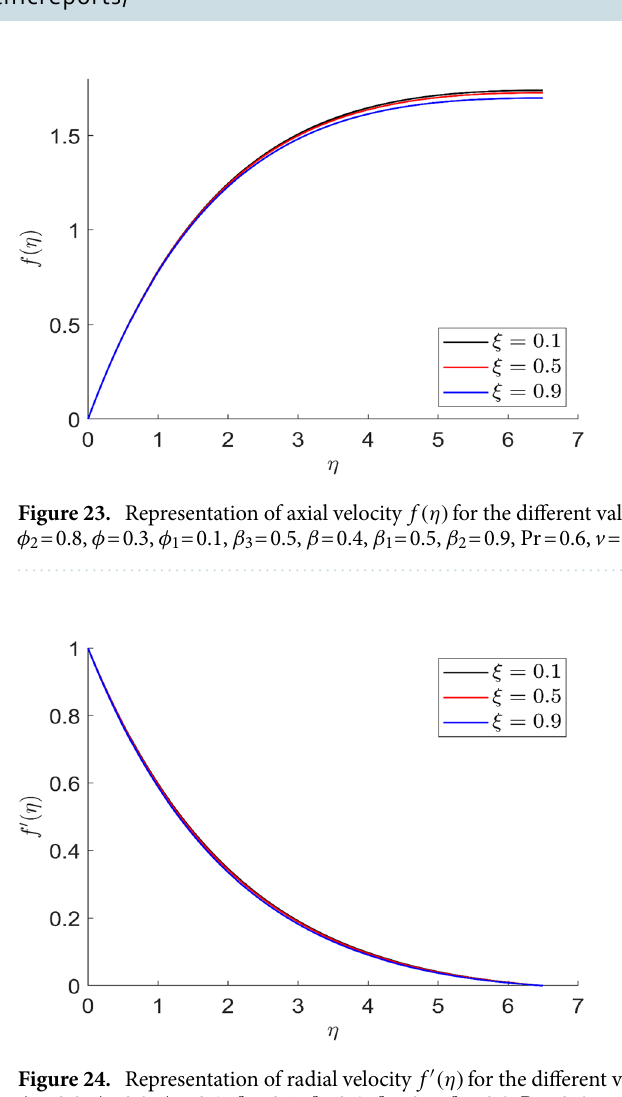
Figure 24. Representation of radial velocity f ′ (η) for the different values of ξ with R = 3, n = 3, u = 0.2, m = 2.5, φ 2 = 0.8, φ = 0.3, φ 1 = 0.1, β 3 = 0.5, β = 0.4, β 1 = 0.5, β 2 = 0.9, Pr = 0.6, v =